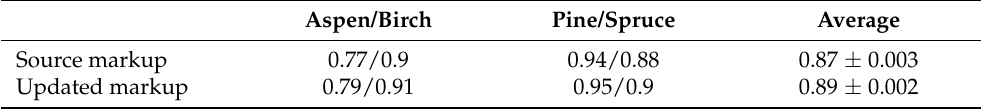
Table 5. Forest types classification for more homogeneous individual stands (per-pixel F1-metric) using source markup and updated markup. Results on test samples.